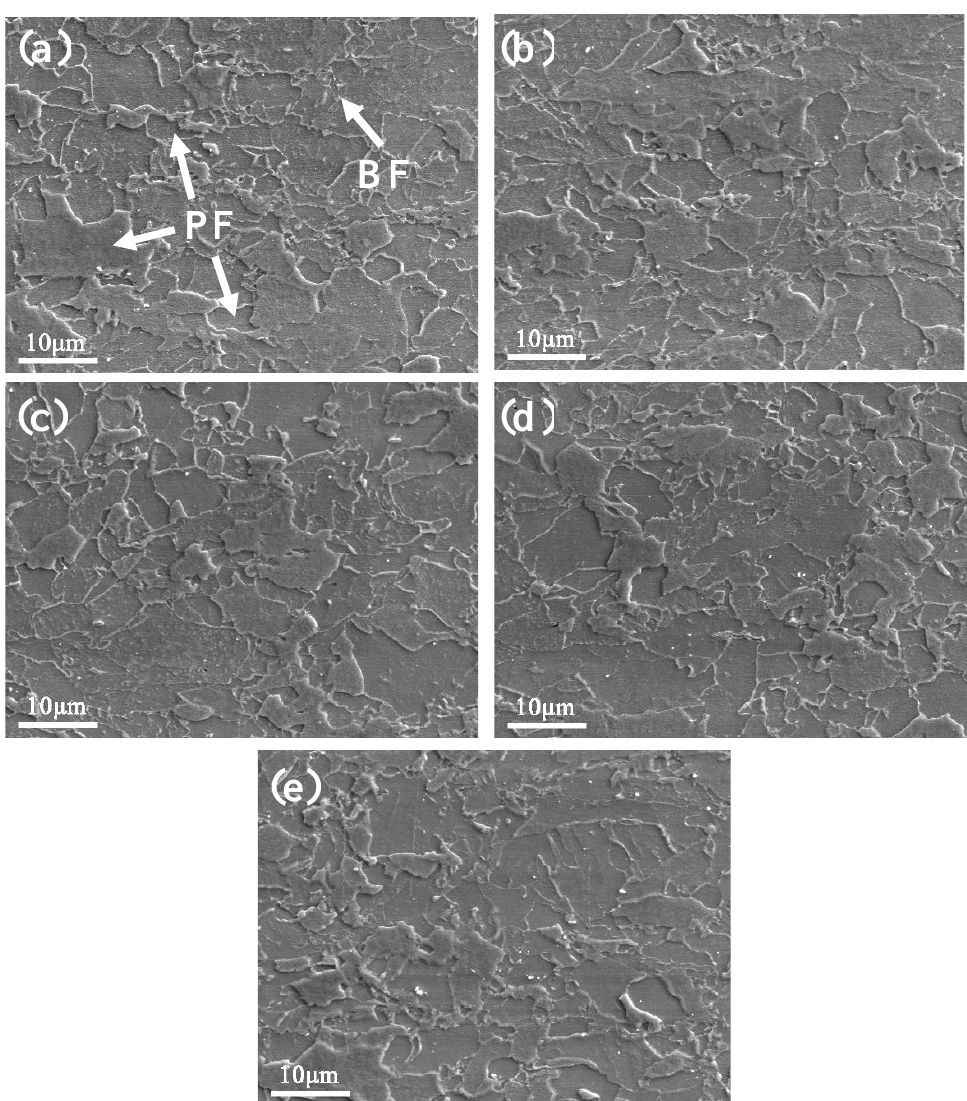
Figure 2. SEM images of the tested steel samples: ( a ) after water cooling; and after aging at 500 °C for ( b ) 0.5 h; ( c ) 1 h; ( d ) 1.5 h; and ( e ) 3 h.